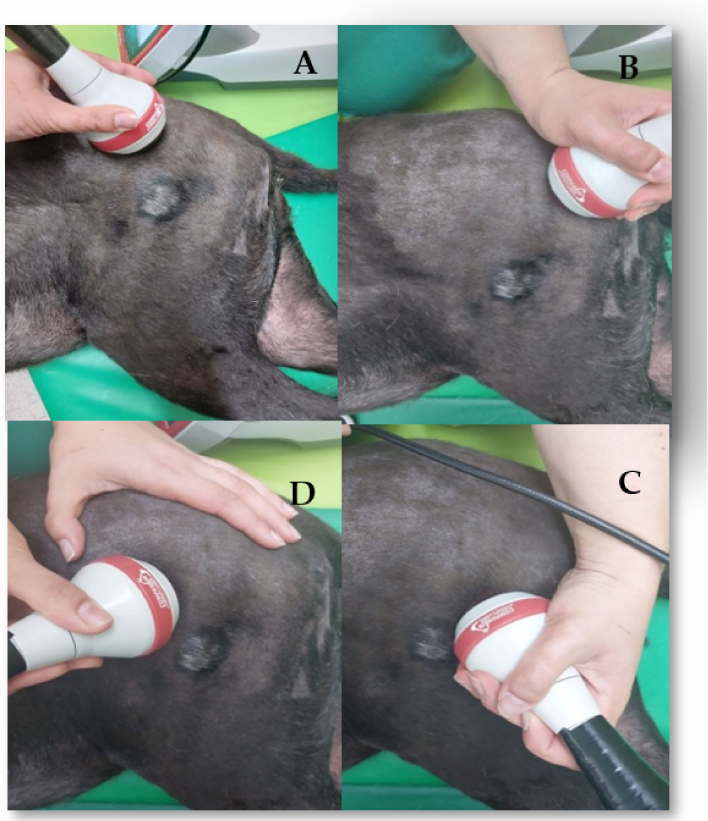
Figure 4. Laser therapy class IV program applied to the coxofemoral joint using the four-point technique. ( A ) Proximo cranial region; ( B ) proximo caudal region; ( C ) disto caudal region; ( D ) disto cranial